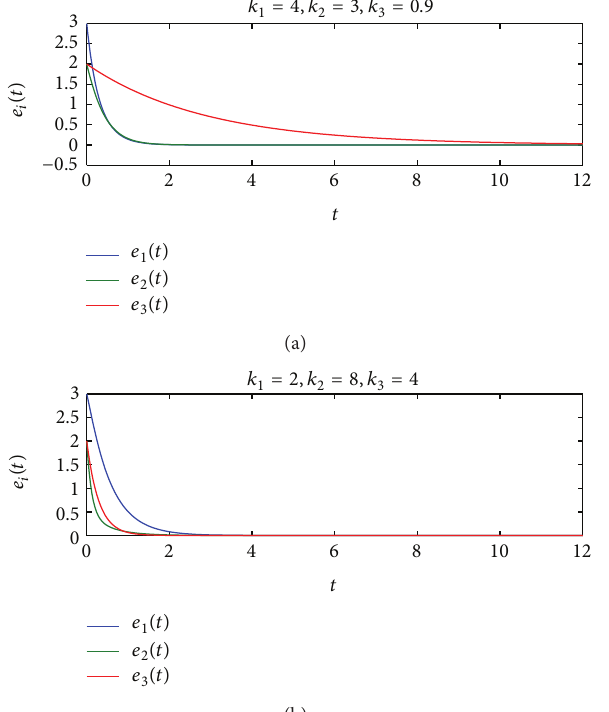
Figure 3: Convergence of ‖𝑒(𝑡)‖ for different parameter choices of the hybrid controller.